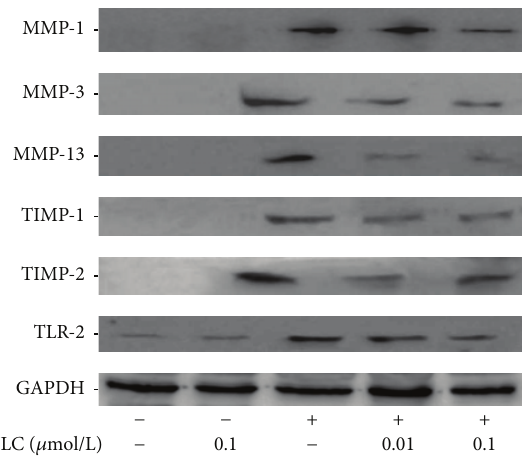
Figure 3: The effects of ATRA-NLCs on MMP-1, MMP-3, and MMP-13 and TIMP-1 and TIMP-2 TLR 2 expression in RCFs stim- ulated with zymosan. RCFs were incubated with or without ATRA- NLC for 24 h and then treated with zymosan. The immunoblot analysis showed that ATRA-NLCs inhibited the zymosan-mediated stimulation of MMP-1, MMP-3, and MMP-13 and TIMP-1 and TIMP-2 TLR 2